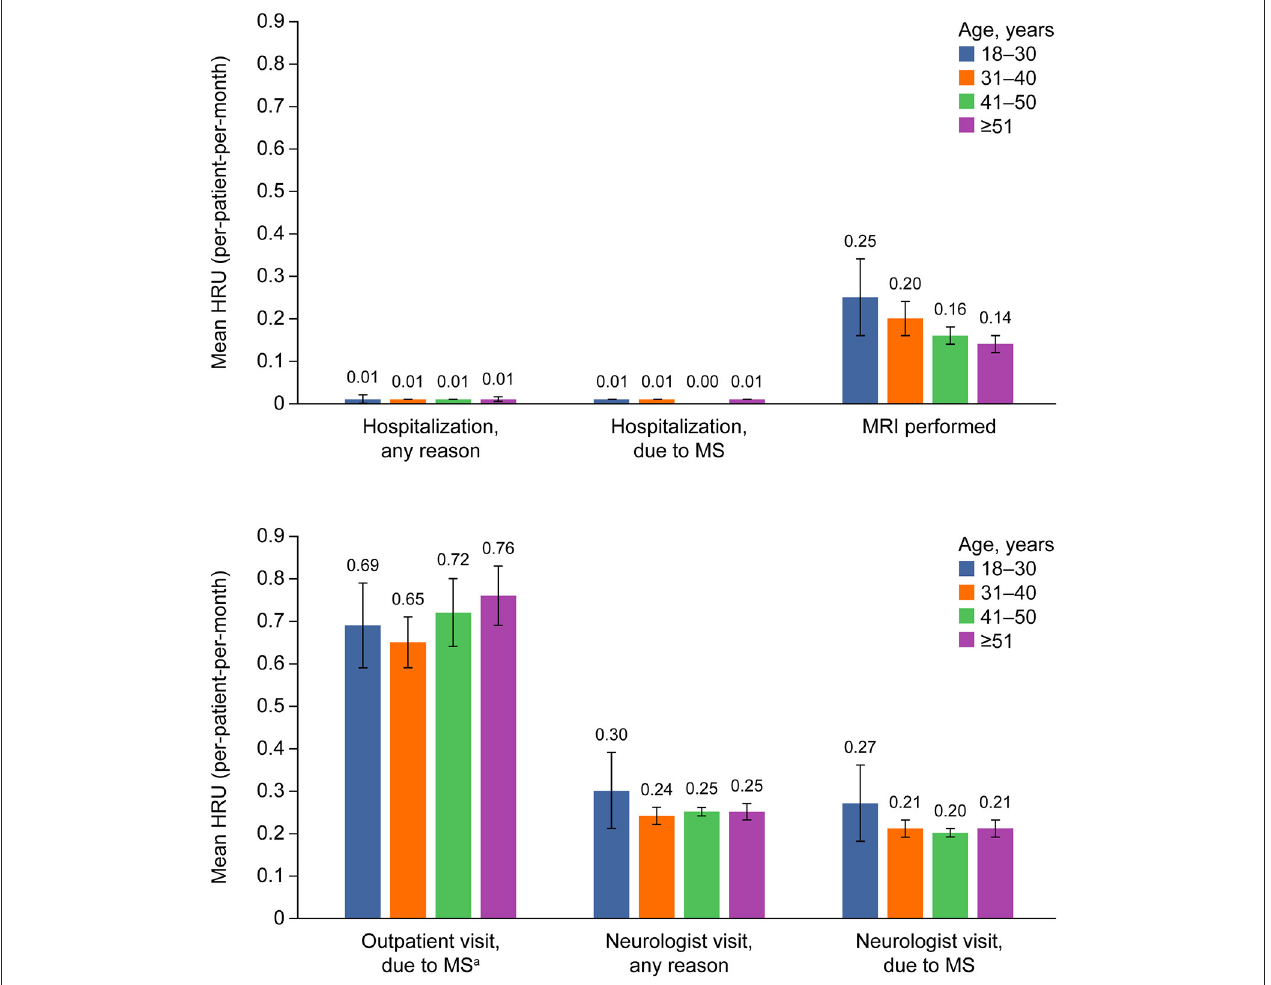
FIGURE 4 | Health care utilization over 1 year after treatment initiation, according to age group. Error bars show the 95% CIs for each outcome by age. a Out-patient visits include: visits with neurologist, general practitioner, and nurse; hospital visits, and emergency room visits. Excluded: visits with psychologist, psychiatrist, speech therapist, and rehabilitation. HRU, healthcare resource utilization; MRI, magnetic resonance imaging; MS, multiple